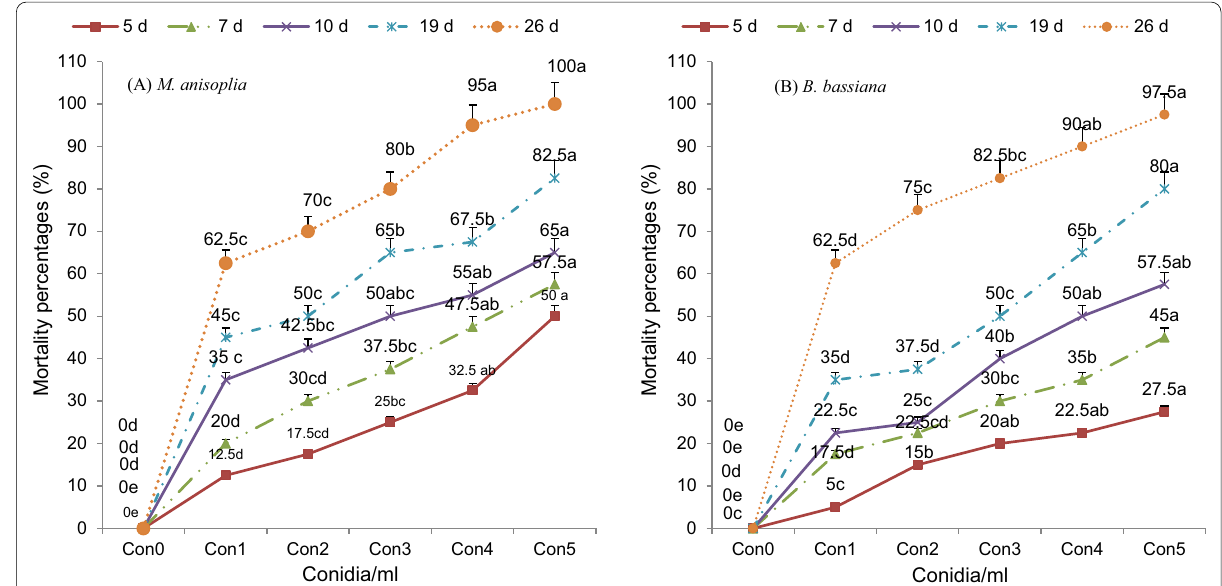
Fig. 2 Accumulated mortality percentages of Bactrocera zonata adults at five time intervals, treated in the larval stage with different concentrations of Metarhizium anisopliae ( A ) and Beauveria bassiana ( B ) fungus under laboratory conditions. Concentrations on x‑axis represent Con0 Con1 2.0 10 5 ‑, Con2 4.0 10 5 ‑, Con3 6.0 10 5 ‑, Con4 1.2 10 6 ‑, Con5 2.3 10 6 ‑Conidia/ml. Error bars indicate the = × = × = × = × = × means sharing similar style letters do not significantly differ at a probability level of 5%